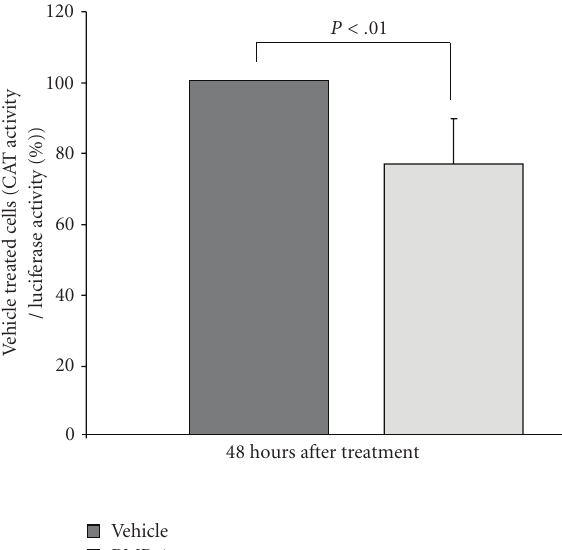
Figure 7: E ff ects of BMP-4 on the promoter activity of PKC - β . In order to determine whether BMP-4 a ff ects promoter activity of PKC- β , paired cultures of LH melanoma cells were transfected with PKC- β promoter CAT reporter construct along with promoter-less renilla luciferase to assess the transfection e ffi ciency, and treated with BMP-4 for 48 hours. Cells were harvested and CAT and Luciferase activities were performed. A total of eight separate transfections were performed, data were pulled and expressed as a percent of vehicle-treated samples. BMP-4 decreased the promoter activity of PKC- β by 25 ± 5% ( P < .